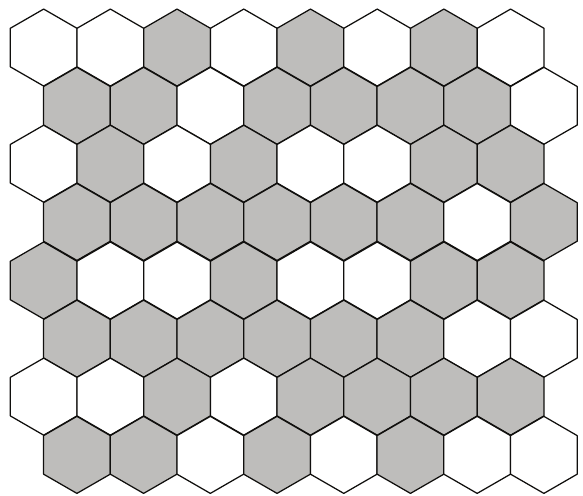
Figure 6: 6 × 6 test network optimal solution with reporting cells configuration.